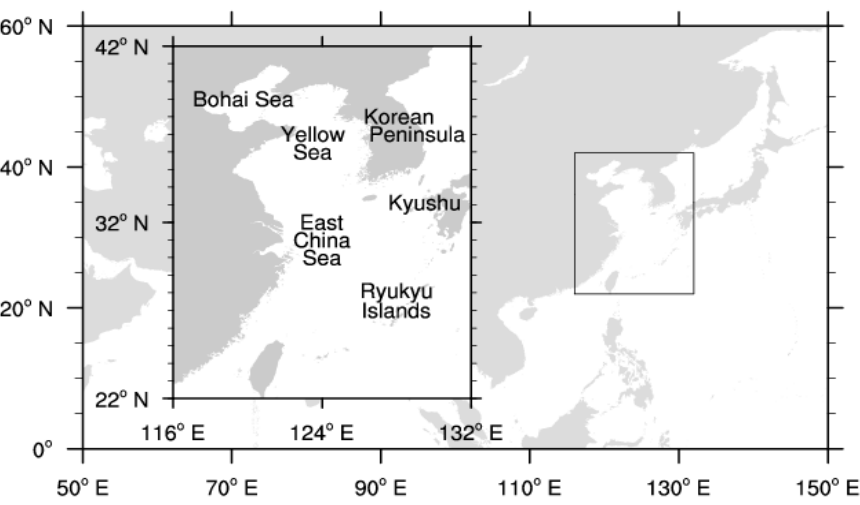
Figure 1. Map showing the geographical location of the study region, including the Bohai Sea, the Yellow Sea, the East China Sea, and adjacent